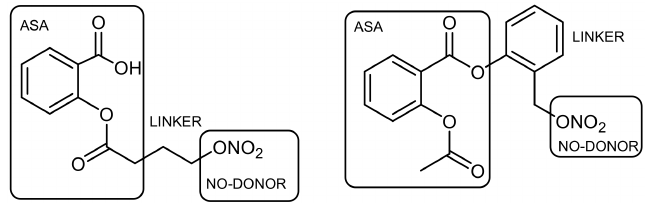
Figure 2. NO-donor aspirin-like linked compounds.